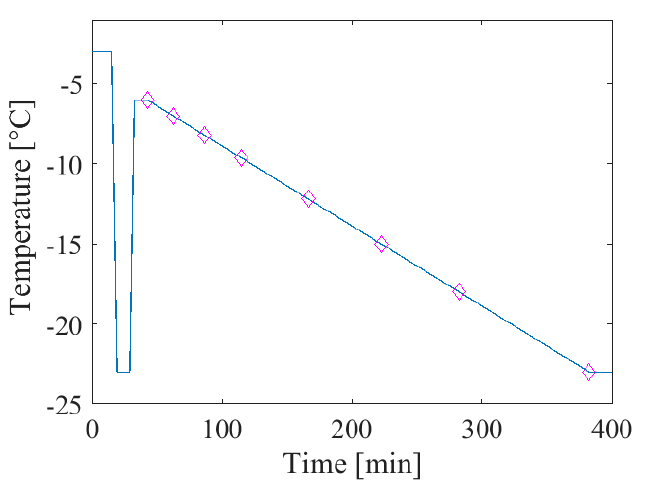
Figure 3. The thermal history of the ice cream mixture specimen during the in situ coarsening experiments. The temperature points where the tomographic scans were reconstructed are indicated as pink diamond